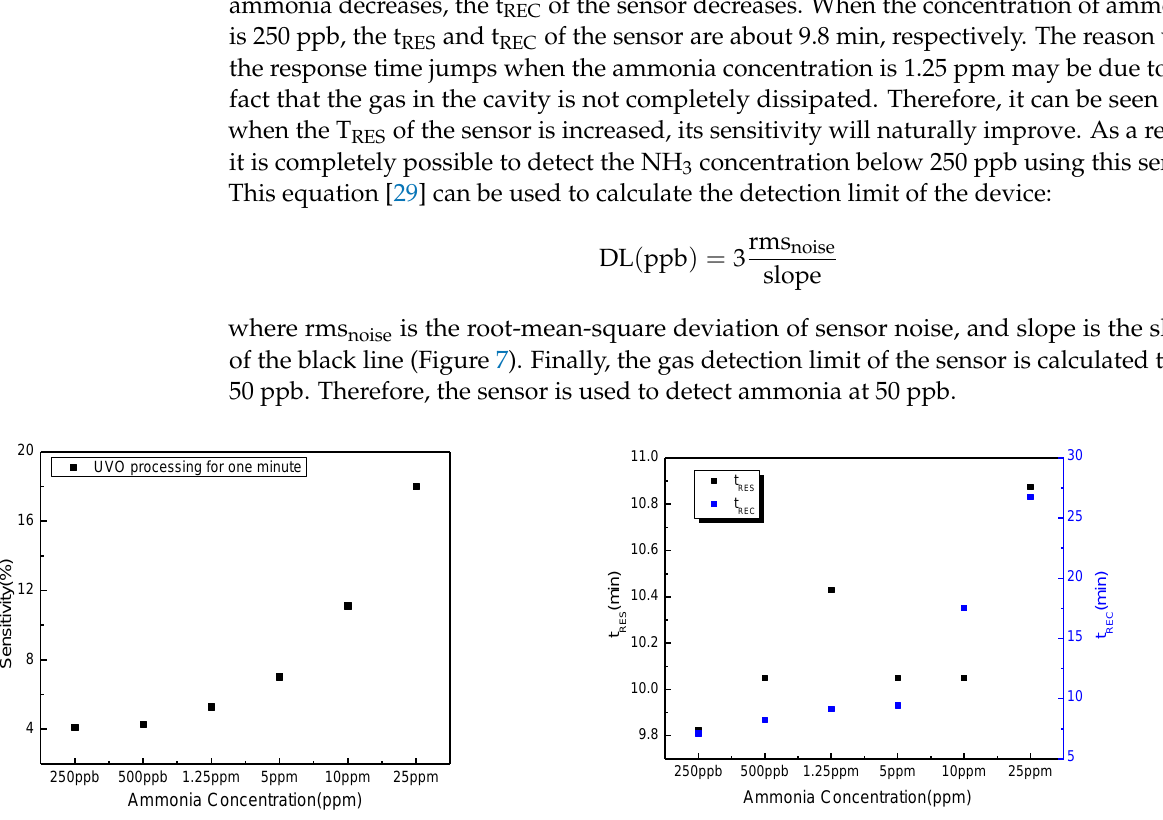
Figure 9. Response curve of the UVO 1-min sample sensor under a low concentration of ammonia.